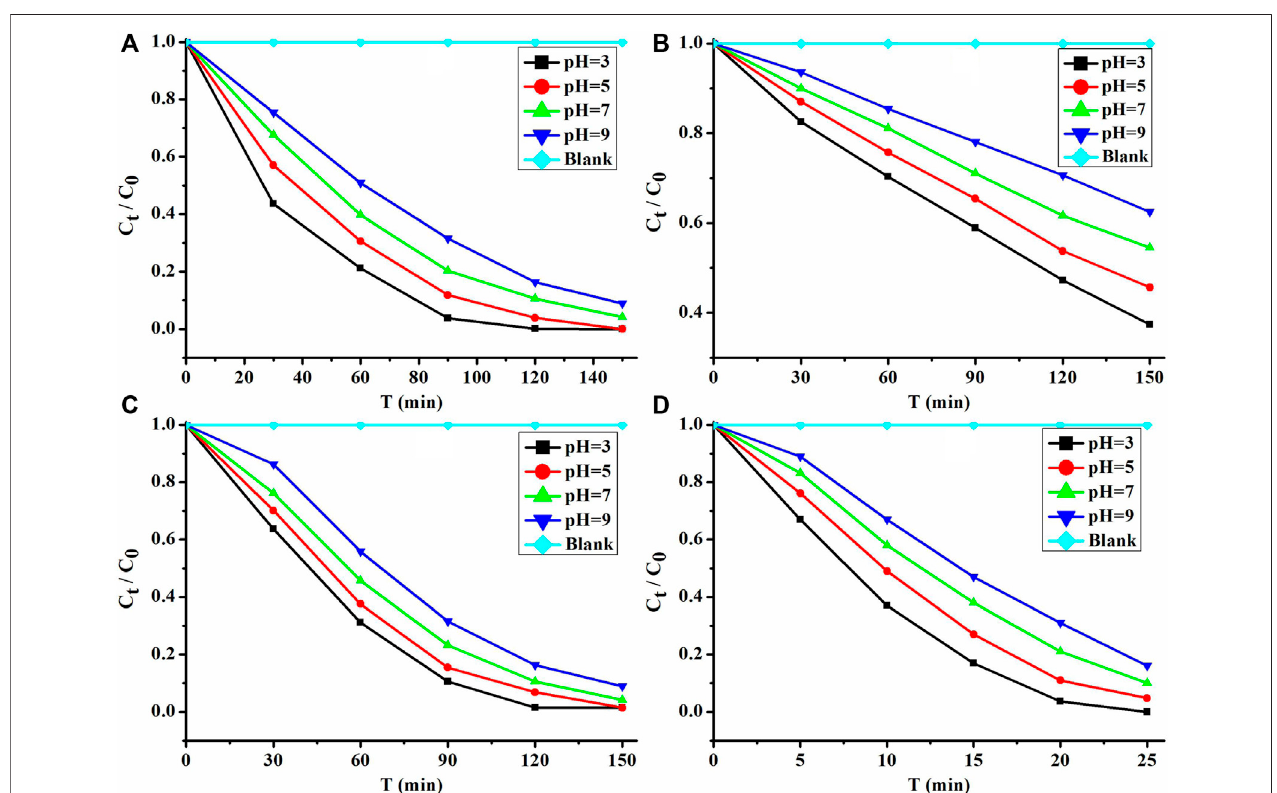
FIGURE 5 | Performance of photocatalytic degradation of MB: (A) 1 , (B) P25, (C) UIO-66-NH 2 , and (D) nanosheets of 1 .